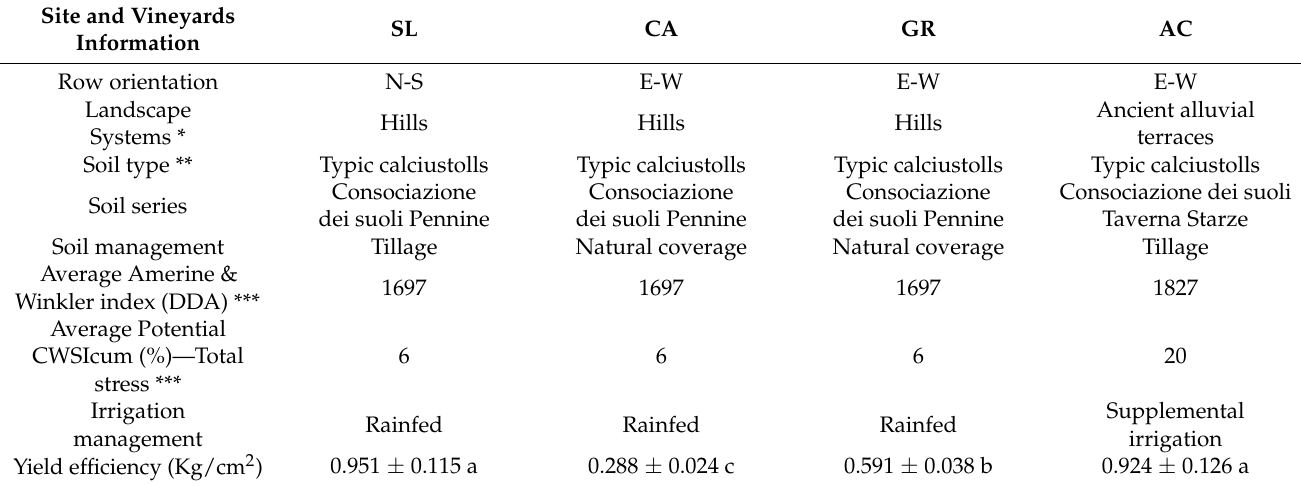
Table 1. Information on environmental and productivity at the four sites (SL—Santa Lucia, CA— Calvese, GR—Grottole, and AC—Acquefredde). For yield efficiency, mean values and standard errors are shown; different letters correspond to significant